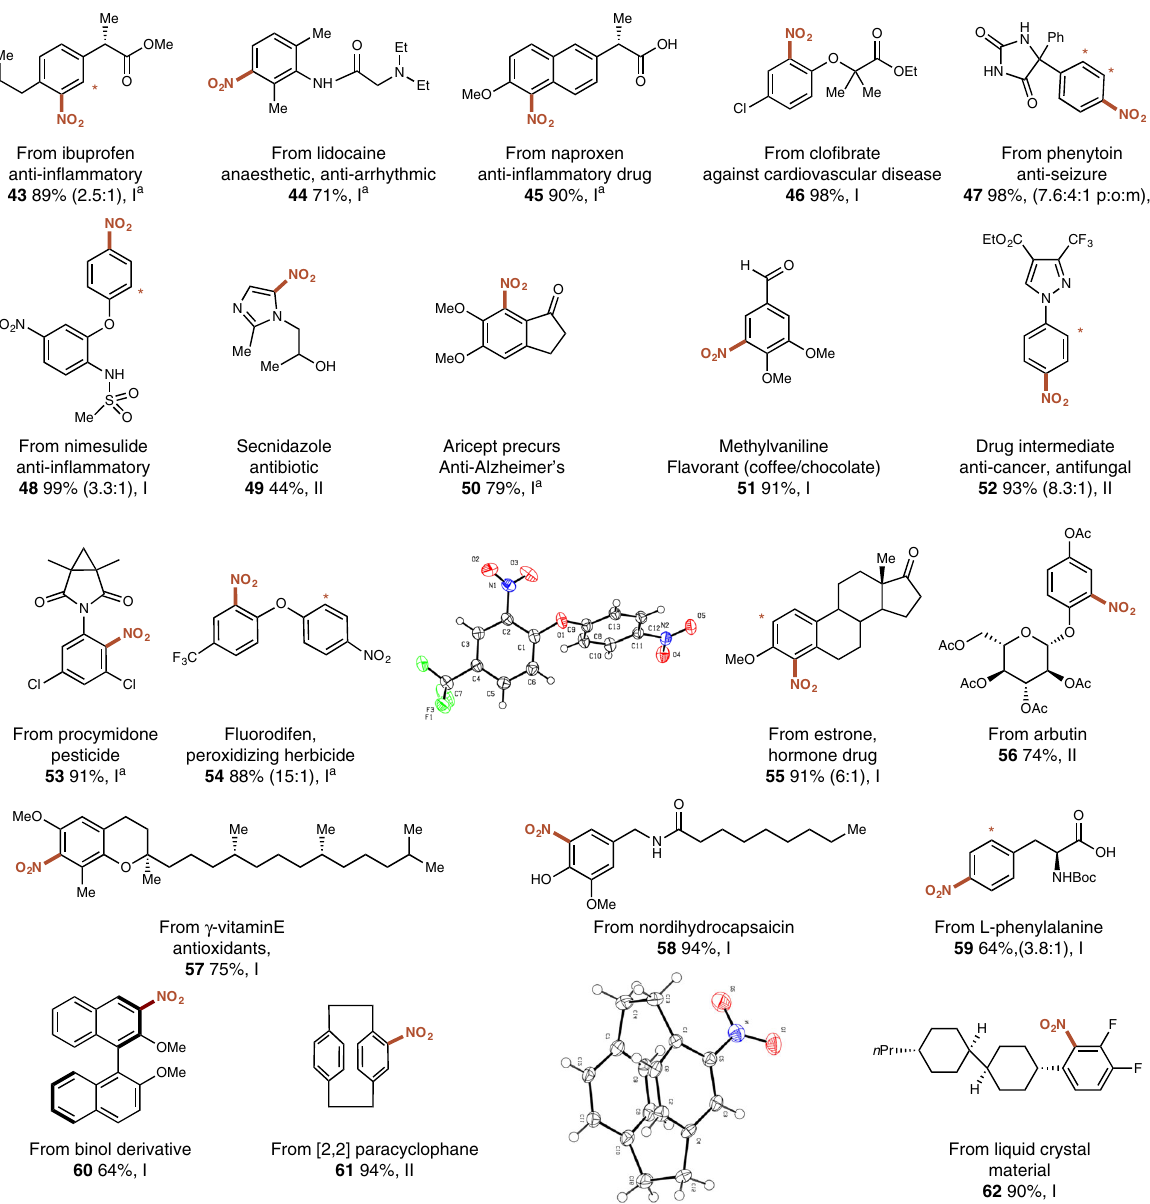
Fig. 3 Direct electrophilic nitration of complex molecules and biorelevant compounds using 4a . Standard procedures: I (Hetero)arene (0.5 mmol), 4a (0.65 mmol), HFIP (0.5 M), 55 °C, 3 h ([a], 19 h); II (Hetero)arene (0.5 mmol), 4a (0.65 mmol), [Mg(ClO 4 ) 2 ] (10 mol%), CH 3 CN (0.5 M), 85 °C, 5 h ([a], 19 h). Yields refer to the isolated product of a single regioisomer or a sum of separately isolated regioisomers. [*] The minor regioisomeric position